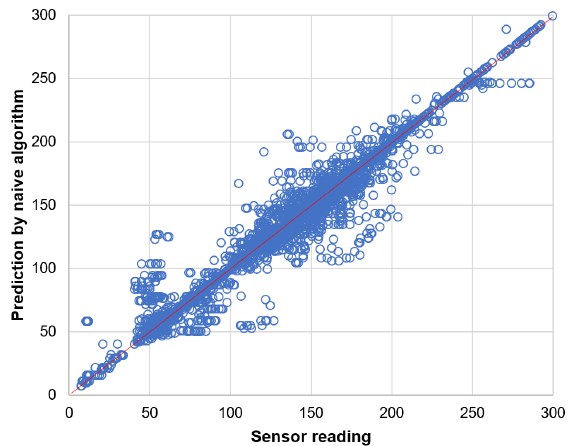
Figure 14. Prediction of light sensor readings by naive algorithm.